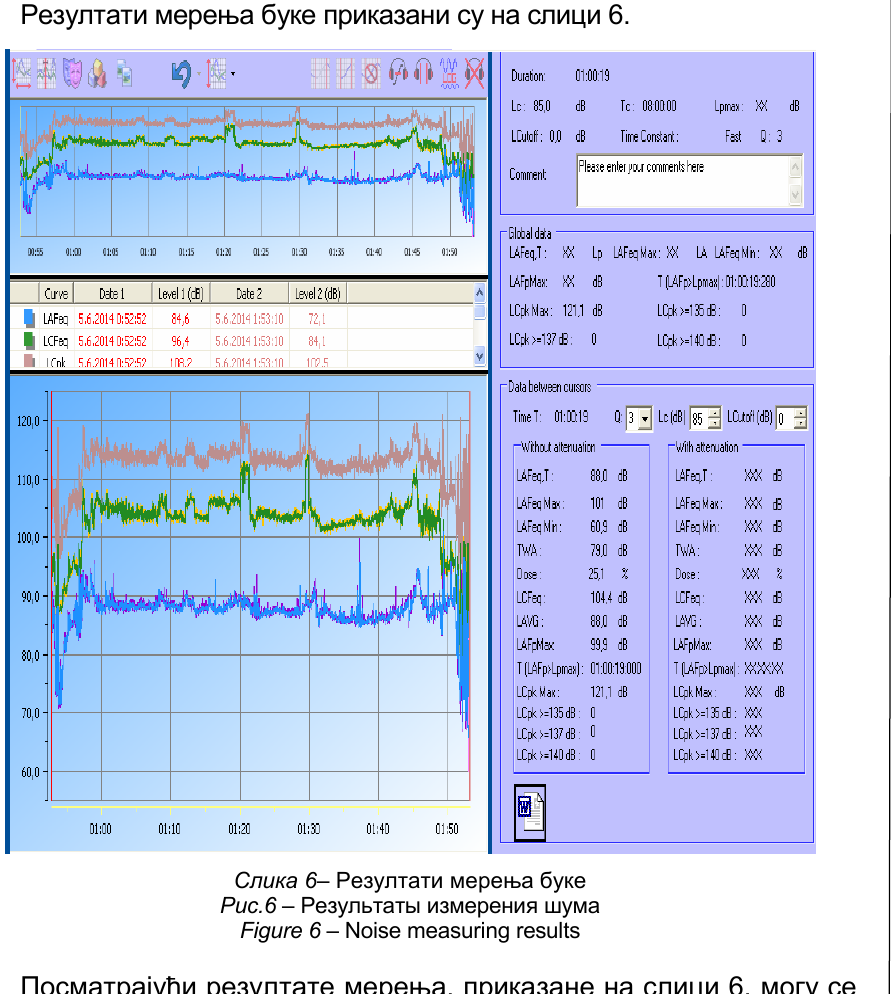
Figure 6 – Noise measuring